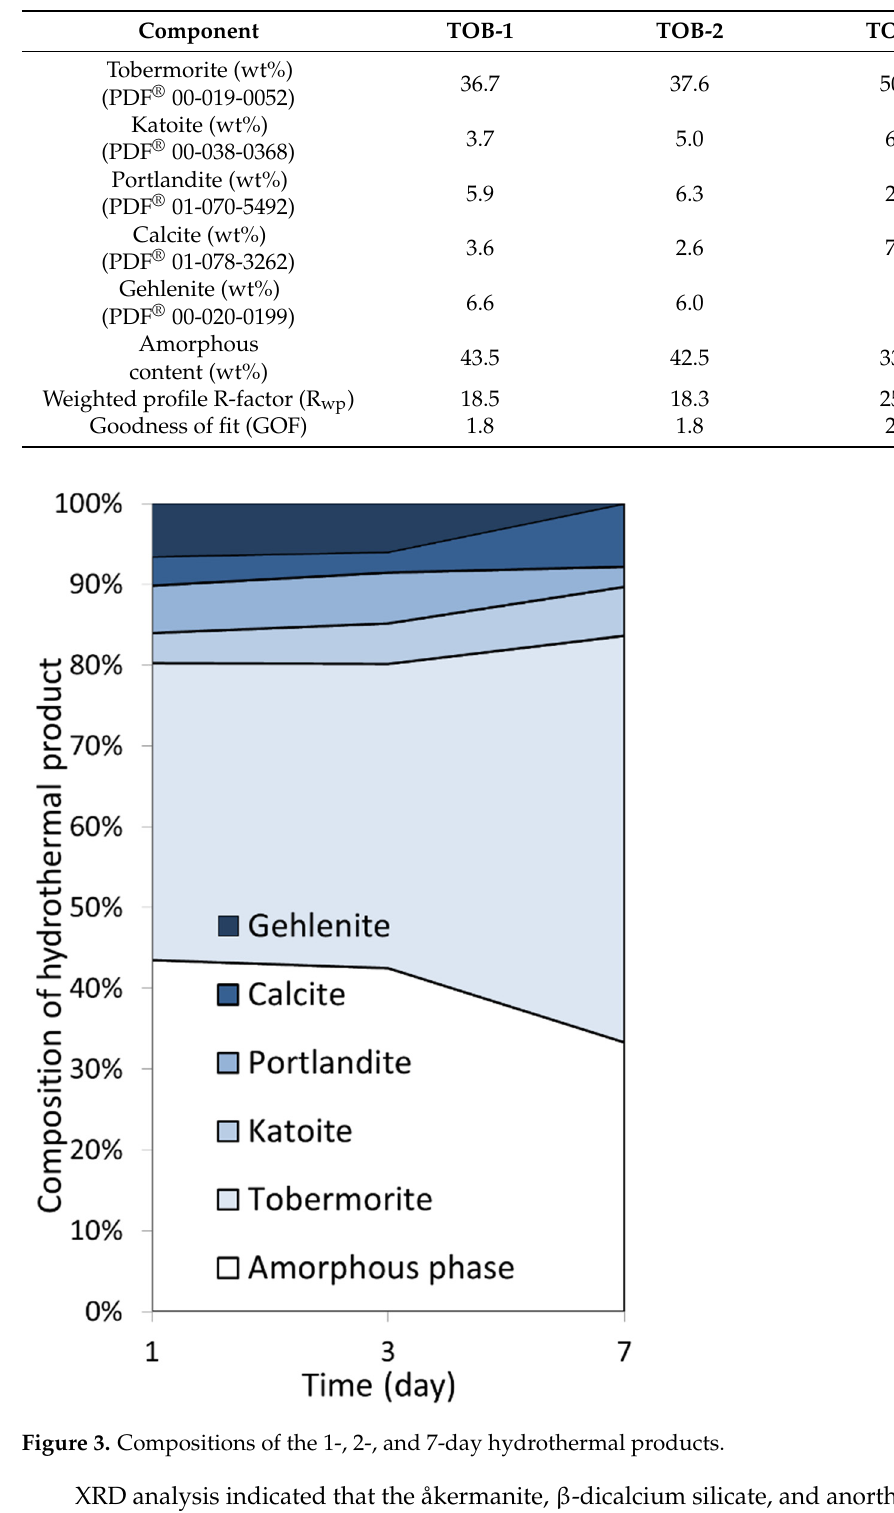
Table 2. Compositions of the hydrothermal products.